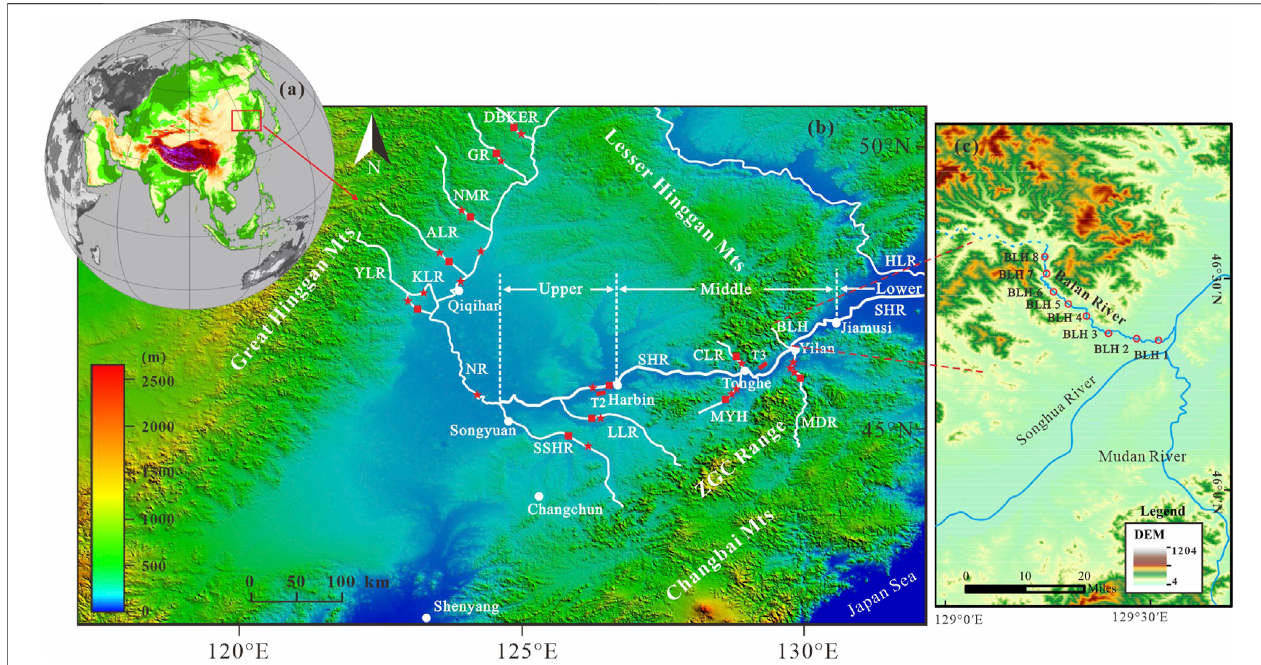
FIGURE1|(A,B) DEMmap ofNortheasternPlain,showingthedistributionoftheSonghua Riverand LiaoheRiverdrainagesystem. Thered fi ve-pointed starsand squaresalongthemajormainstemandtributariesrepresentthesamplesitesusedinthisstudyfordifferentgrain-size(63 – 125 μ mand125 – 250 µm)andwidegrain-size window(63 – 250 µm)heavymineralanalysis,respectively.Thered fi lledrectanglerepresentthe fl uvialterracesite. (C) DEMmapoftheBalanRiver,showingtheintensive sampling sites for the eight samples. Abbreviation: HLR = Heilong River; NR = Nenjiang River; SHR = Songhua River; SSHR = Second Songhua River; LLR = Lalin River; CLR = Chalin River; MYR = Mayan River; BLH = Balan River; MDR = Mudan River; DBKER = Duobukuer River; GR = Ganhe River; NMR = Nuomin River; ALR = Alun River; YLR = Yalu River; KLR = Kule River; ZGC Range = Zhangguangcai Range. (For interpretation of the references to colour in this fi gure legend, the reader is referred to the web version of this